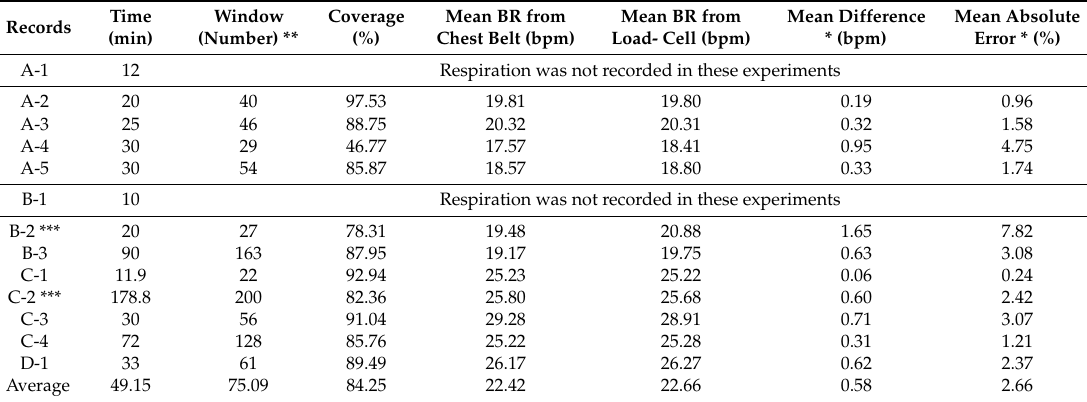
Table 6. Comparison of BRs calculated from commercial device and proposed